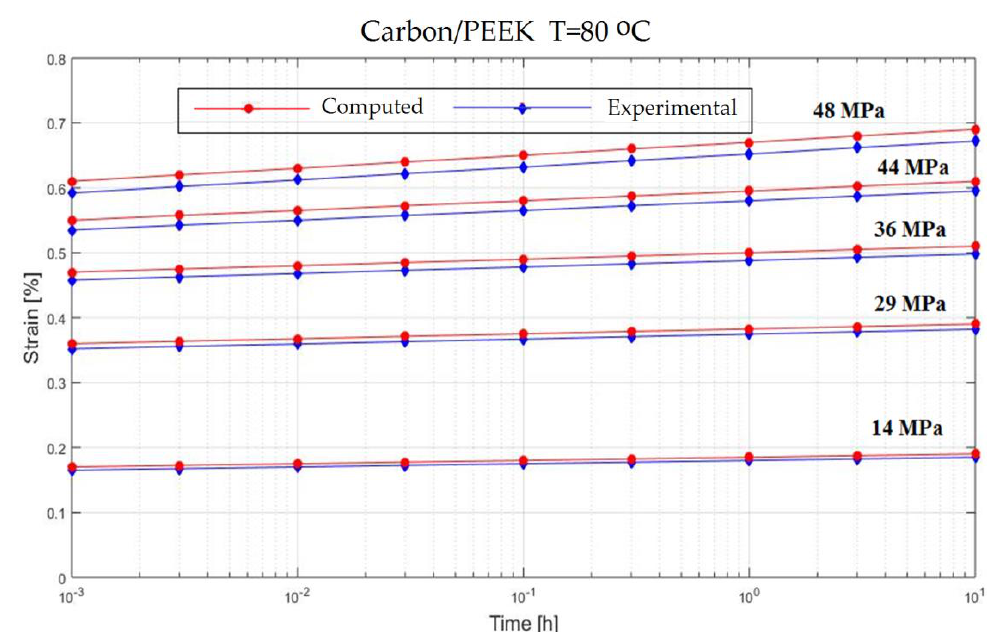
Figure 6. Creep response of a carbon/epoxy {90} 4s at T = 80 ° C.